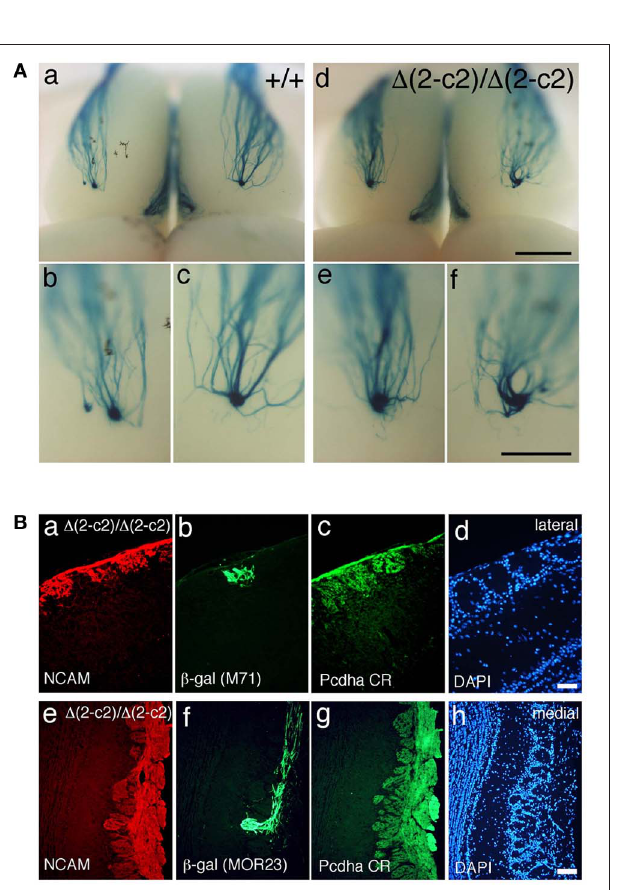
FIGURE 7 | Axonal coalescence of OSN projections in Pcdha (cid:2)( 2–c2 )/(cid:2)( 2–c2 ) mice. (A) X-gal-stained dorsal M71 glomeruli in WT ( + / + ) and Pcdha (cid:2)( 2–c2 )/(cid:2)( 2–c2 ) ( (cid:2) (2–c2)/ (cid:2) (2–c2) ) mice at P30. Glomeruli appeared normal in the Pcdha (cid:2)( 2–c2 )/(cid:2)( 2–c2 ) mice. Scale bars, 1mm for panels (a, d), and 500 μ m for panels (b, c, e, and f). (B) Analysis of M71 (b) and MOR23 (f) glomeruli in the Pcdha (cid:2)( 2–c2 )/(cid:2)( 2–c2 ) mice. Sections of OBs were double-labeled with β -galactosidase ( β -gal; green) and NCAM (red) (a, e) antibodies. Each adjacent section (c, d and g, h) was stained with anti-Pcdha CR antibody and 4 (cid:3) ,6-diamidino-2-phenylindole(DAPI; blue). Scale bars, 50 μ m for panels (a–d) and 100 μ m for panels